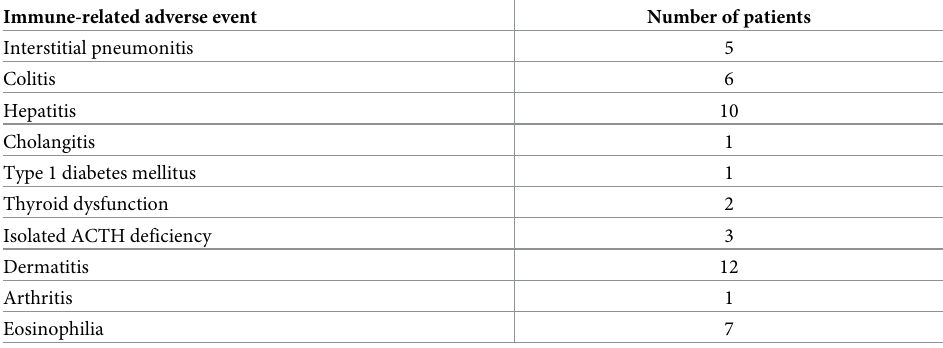
Table 3. Immune-related adverse events.